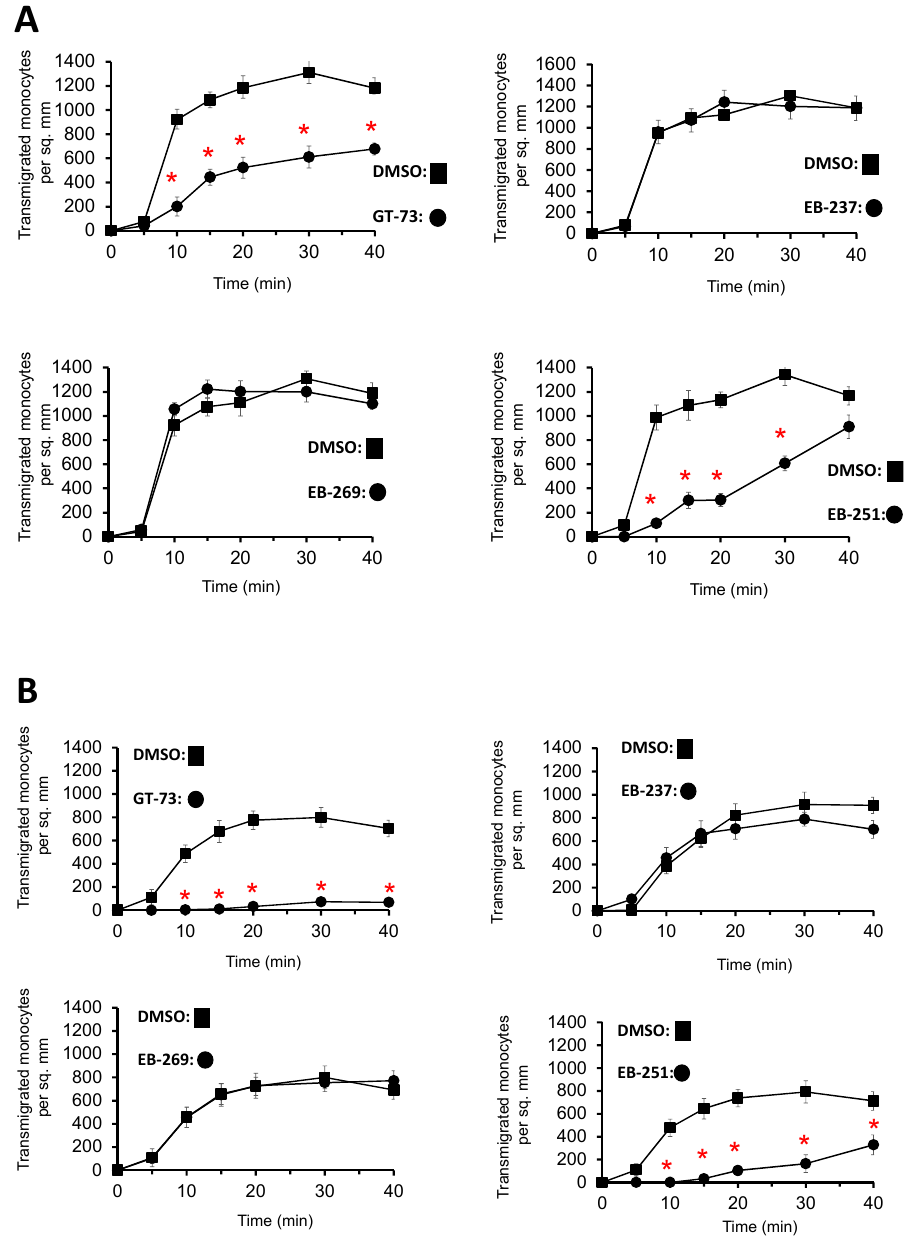
Figure 1. Monocyte transmigration (absolute number) on the surface of the activated HUVECs under flow. Primary human monocytes were cocultured on TNF- α -activated HUVECs. Test compounds at 30 µ M or DMSO (0.1%) were added to cells for 45 min. Cocultures were kept under a flow of 0.05 Pa. Mean ± SE, * p ≤ 0.05. ( A ) First donor. ( B ) Second